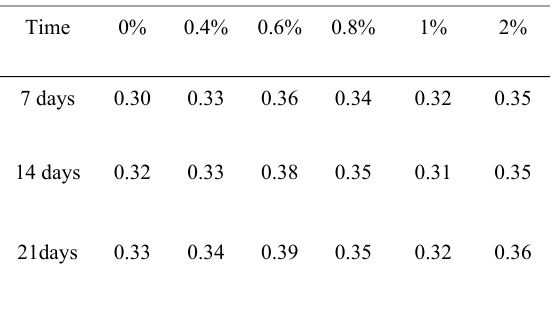
Table 3: Water absorption of polyurethane/silicon oxide nano- composite coatings.